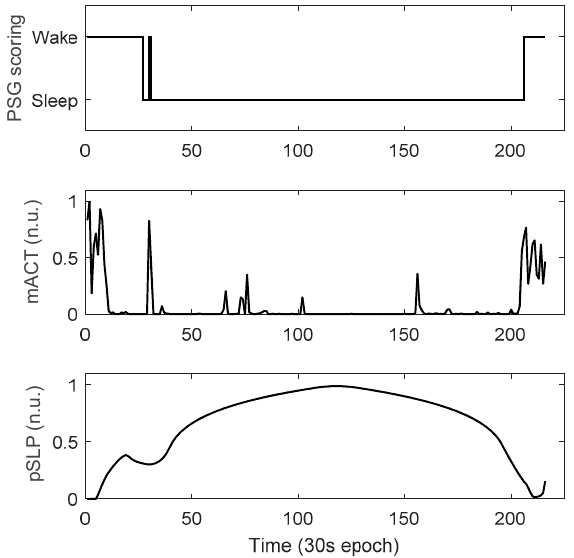
Figure 2. Example of 30 s-based wake and sleep annotations (polysomnography—PSG) and the corresponding feature values of the two features, mean activity count (mACT) and the “possibility” of being asleep (pSLP) (normalized unit: n.u.), from a recording of 216 epochs.